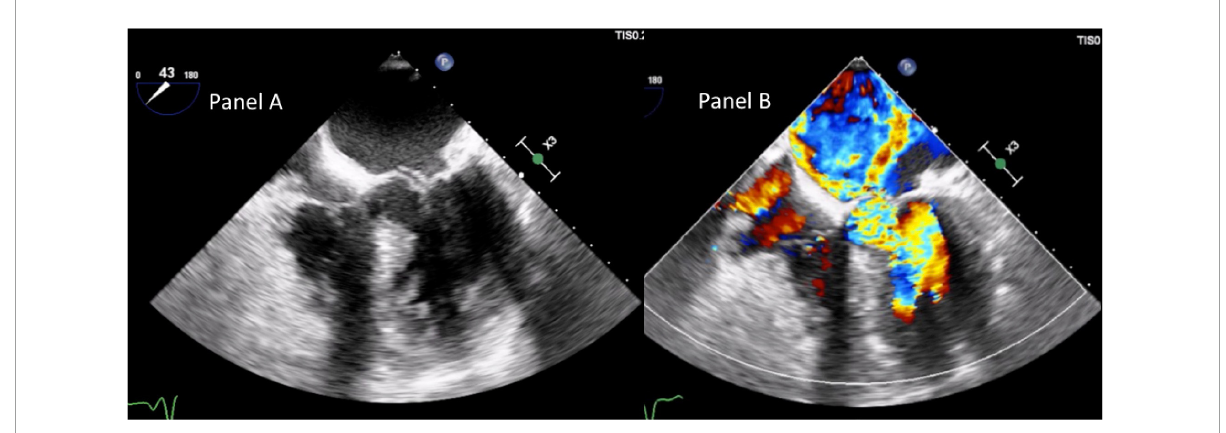
FIGURE3 Trans-esophageal echocardiogram mid-esophageal 5-C view demonstrating, in panel (A) , basal interventricular septum severe hypertrophy, SAM of AML, chordal rupture, and the related PML-flail. Panel (B) shows the two different jets there were at color Doppler. The posteriorly directed jet was due to SAM-related MR. The anteriorly directed jet was related to PML-flail.